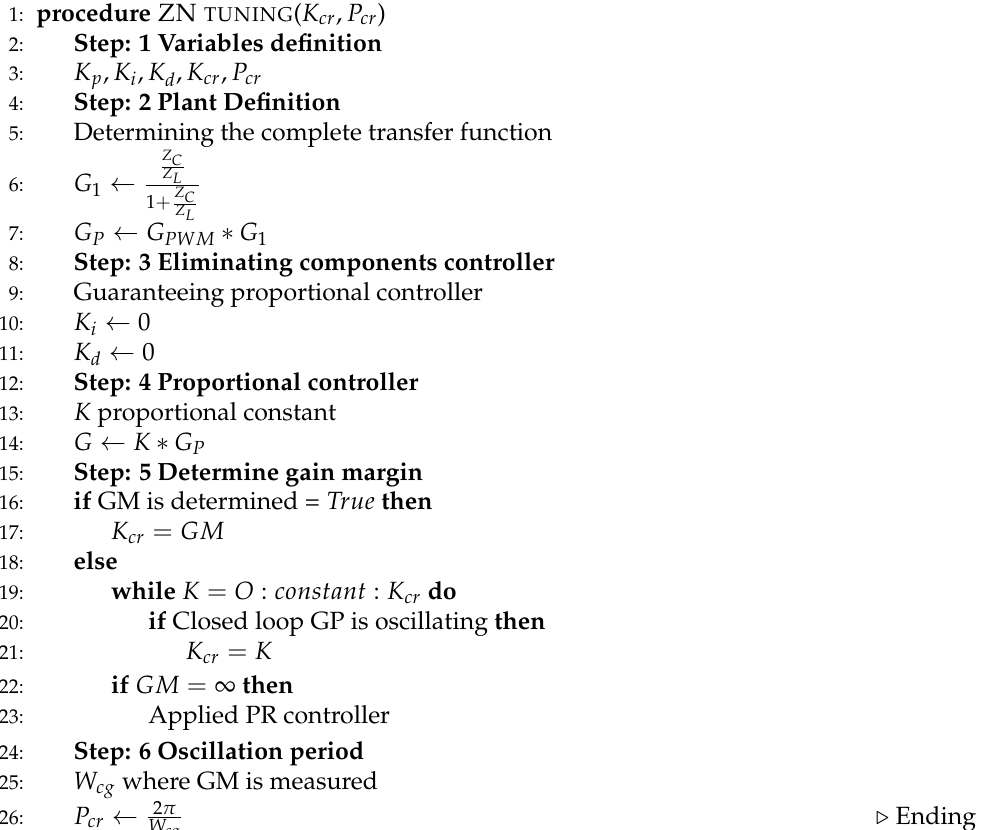
Algorithm 1 Tuning procedure for open loop system using